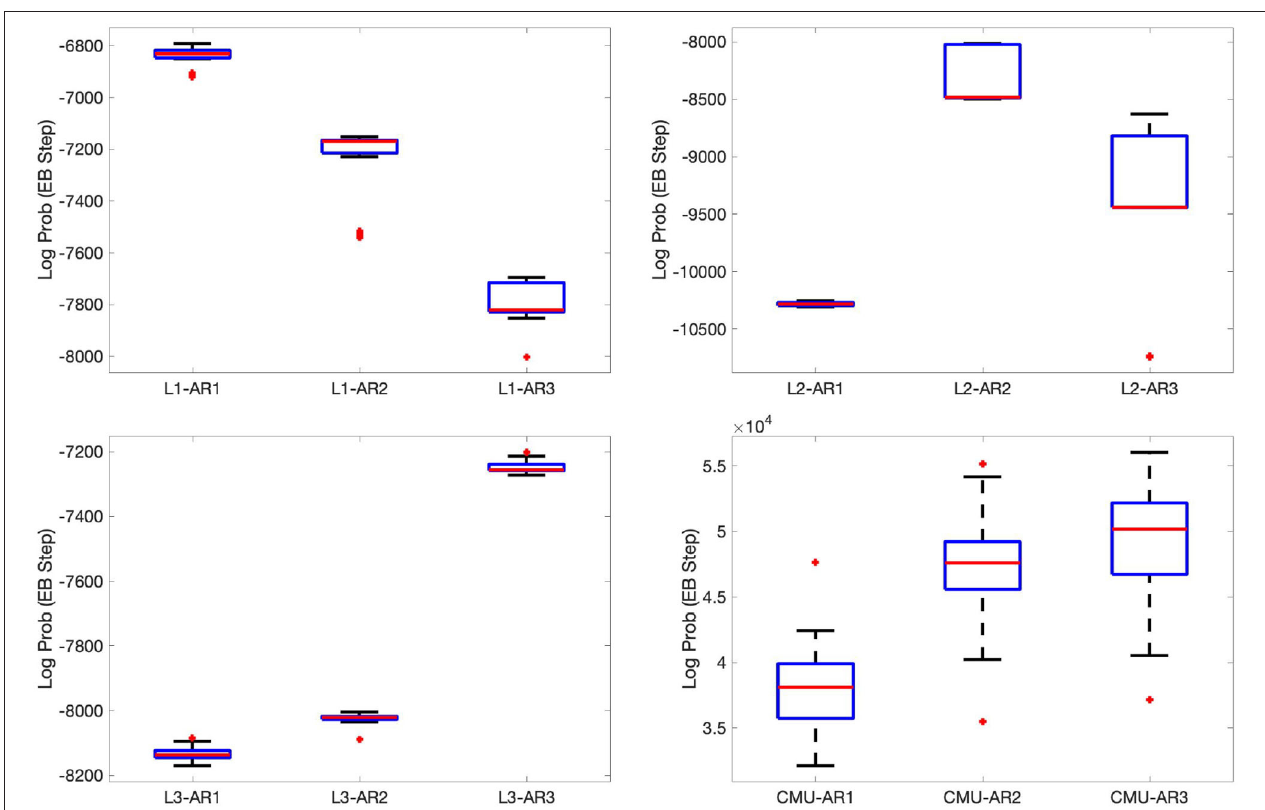
FIGURE 6 | Boxplots of the joint log probabilities P ( y , F , z ) of the EB step. Red line: median. Edges of blue box: first and third quartiles. Whiskers: most extreme data points except outliers.